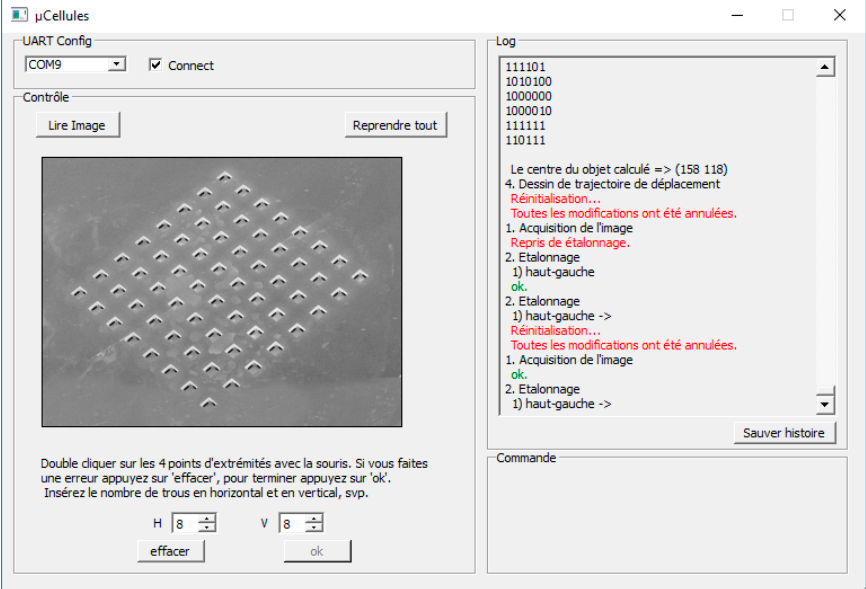
Figure 12. The IPDC unit GUI.